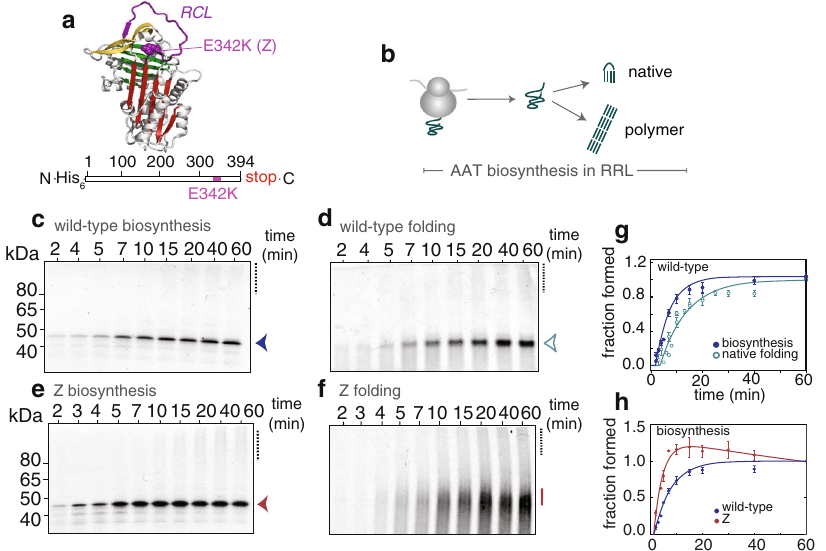
Fig. 1 Monitoring the folding and misfolding of alpha-1-antitrypsin (AAT) during biosynthesis in rabbit reticulocyte lysate (RRL) using 35 S methionine radiolabelling. a (upper) AAT structure (PDB ID: 1QLP) with landmarks highlighted: A-sheet (red), B-sheet (green), C-sheet (yellow), reactive centre loop (RCL, purple), and site of the Z mutation (E342K). (lower ) Schematic of the full-length AAT DNA construct and highlighting the relative position of the Z (E342K) mutation. b Scheme of released AAT biosynthesis and folding in RRL. c Production of wild-type AAT nascent chains as followed by denaturing PAGE. Highlighted are the full-length species (arrow), and high molecular weight species / polymerisation (i.e., a smear) as a dashed line. d Folding of wild- type AAT nascent chains as monitored by native PAGE (using the same samples as in c ). Highlighted is the biologically-active, monomeric species (arrow) and polymer (dashed line). e Production of Z nascent chains as followed by denaturing PAGE. Highlighted are the full-length species (arrow), and high molecular weight species / polymerisation (i.e., a smear) as a dashed line. f Folding of Z AAT nascent chains as monitored by native PAGE (using the same samples as in e ). Unlike wild-type in c , Z nascent chains cannot fold ef fi ciently (solid line) and form polymers (dashed line). g Biosynthesis and native folding of wild-type AAT nascent chains (analysis from c , d ; n = 4). h Biosynthesis of wild-type and Z AAT nascent chains over 60 min. Data have been normalised to the reaction end-point to enable a comparative analysis. All samples were fl ash-frozen and treated with RNase A prior to analysis. ( n = 5 biological repeats). Data are presented as mean values + / −